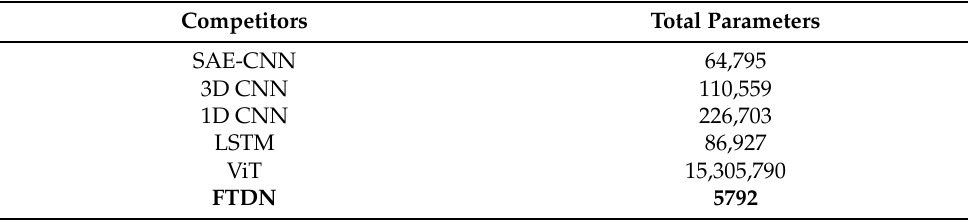
Table 6. The total parameters of different